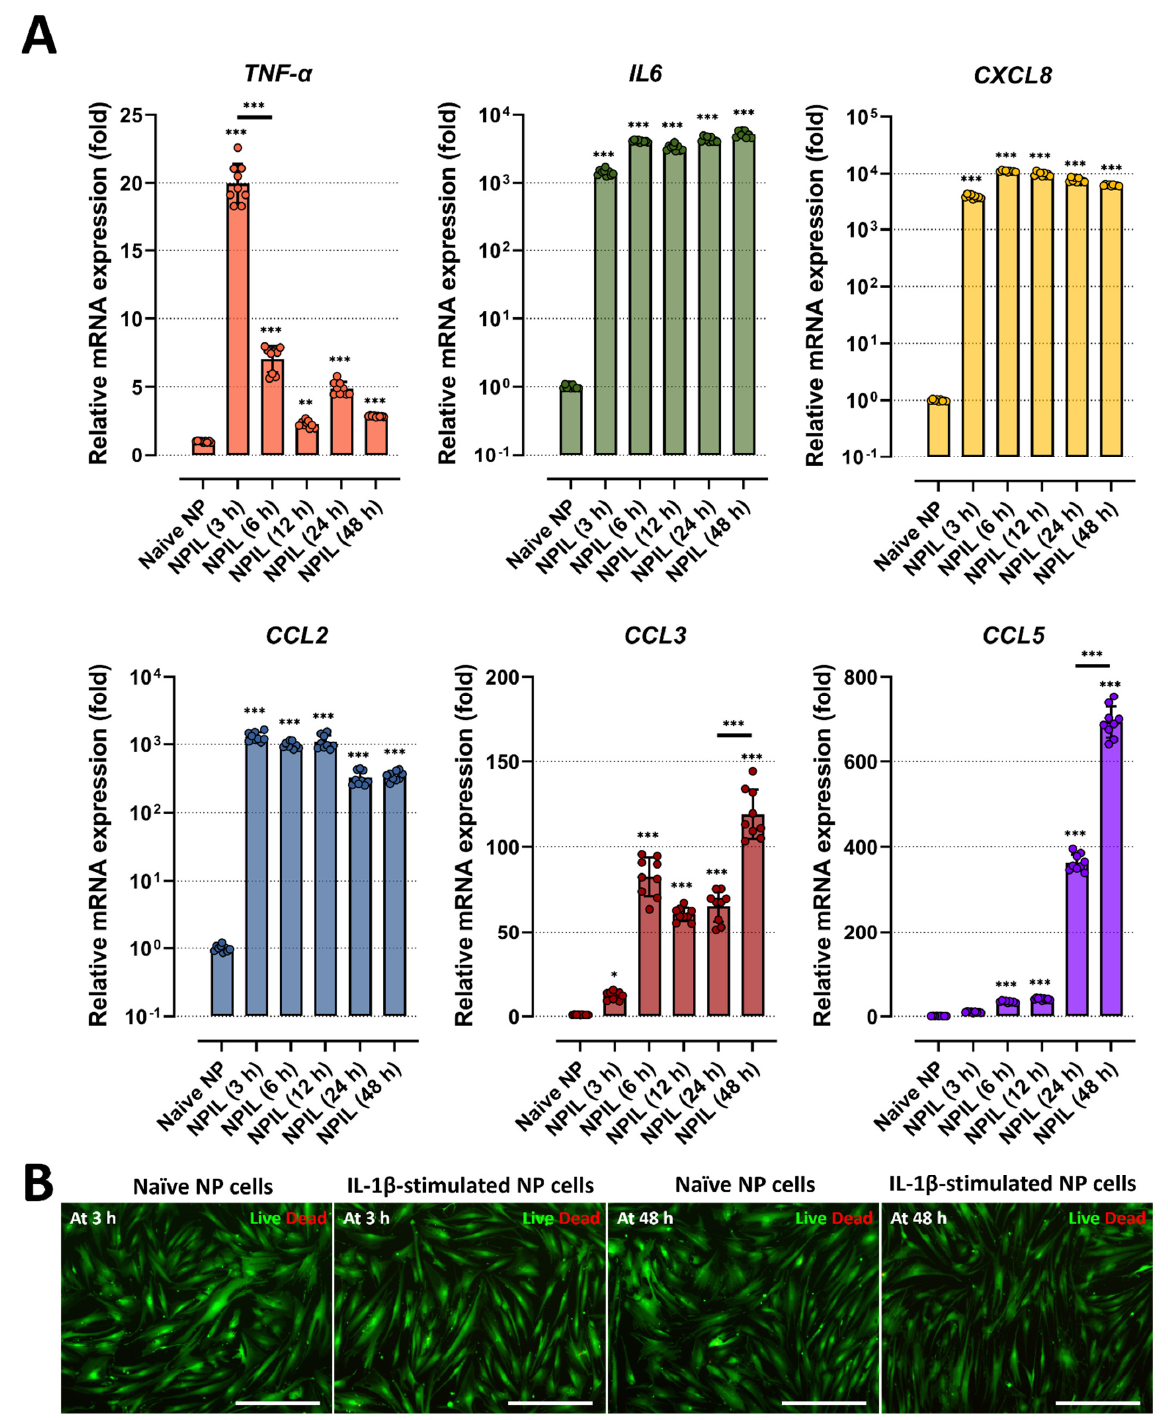
Figure 3. IL − 1 β stimulation induces the gene expression of inflammatory mediators and chemokines on human NP cells. ( A ) Comparison of gene expression for inflammatory cytokines and chemokines from human NP cells with/without IL − 1 β treatment in a time-dependent manner. ( B ) Assessment of cytotoxicity by using Live/Dead assay. The results showed that human NP cells treated with IL − 1 β did not exhibit any difference in cell viability. The values are reported as the mean ± standard error of four independent experiments. Scale bars, 225 µ m. * p < 0.05, ** p < 0.01, and *** p < 0.001 as compared with naïve NP cells. The line indicates the comparison with each